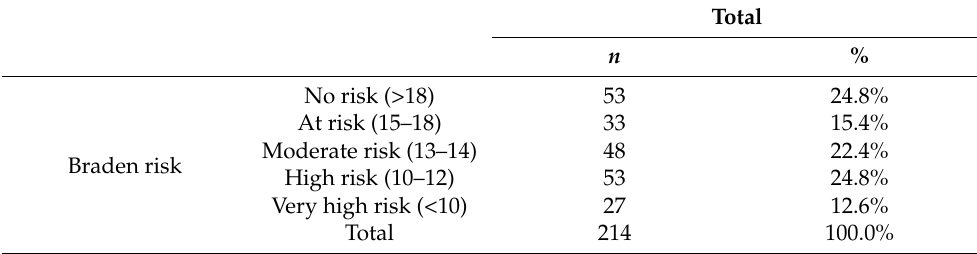
Table 6. Pressure injury Braden